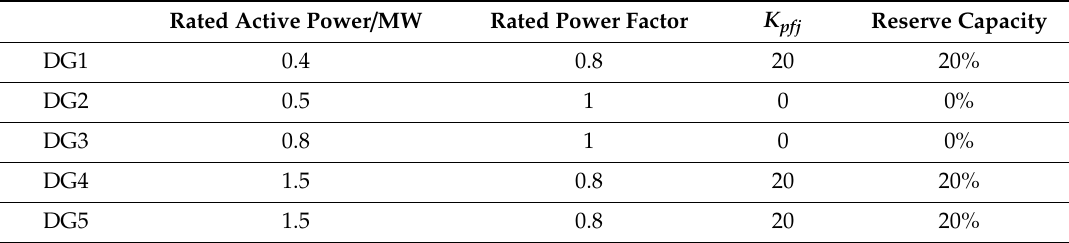
Table A1. Concrete parameters of the 5